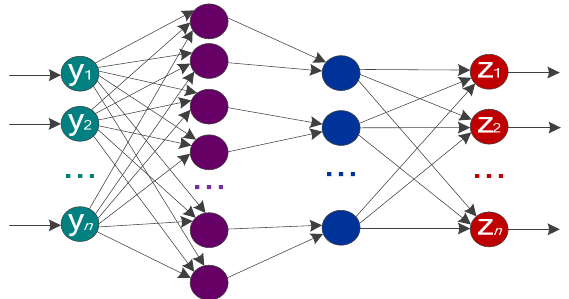
Figure 2. PNN topology diagram.